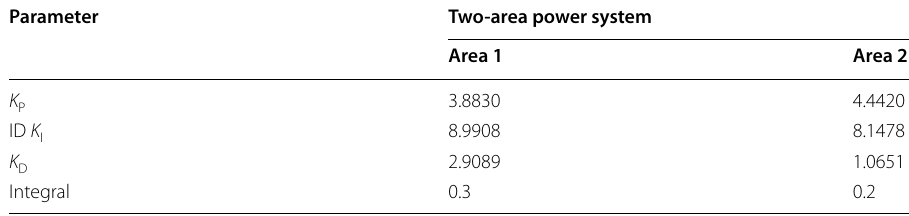
Table 9 WCA optimal value of PID controller and integral controller value